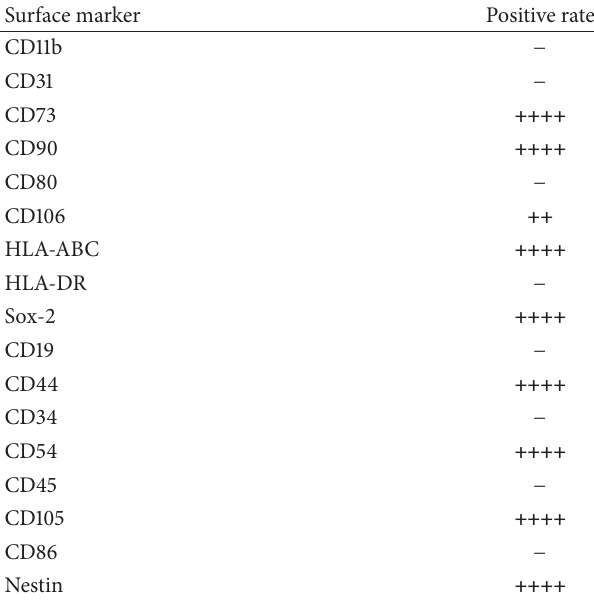
Table 1: Immunophenotypes of